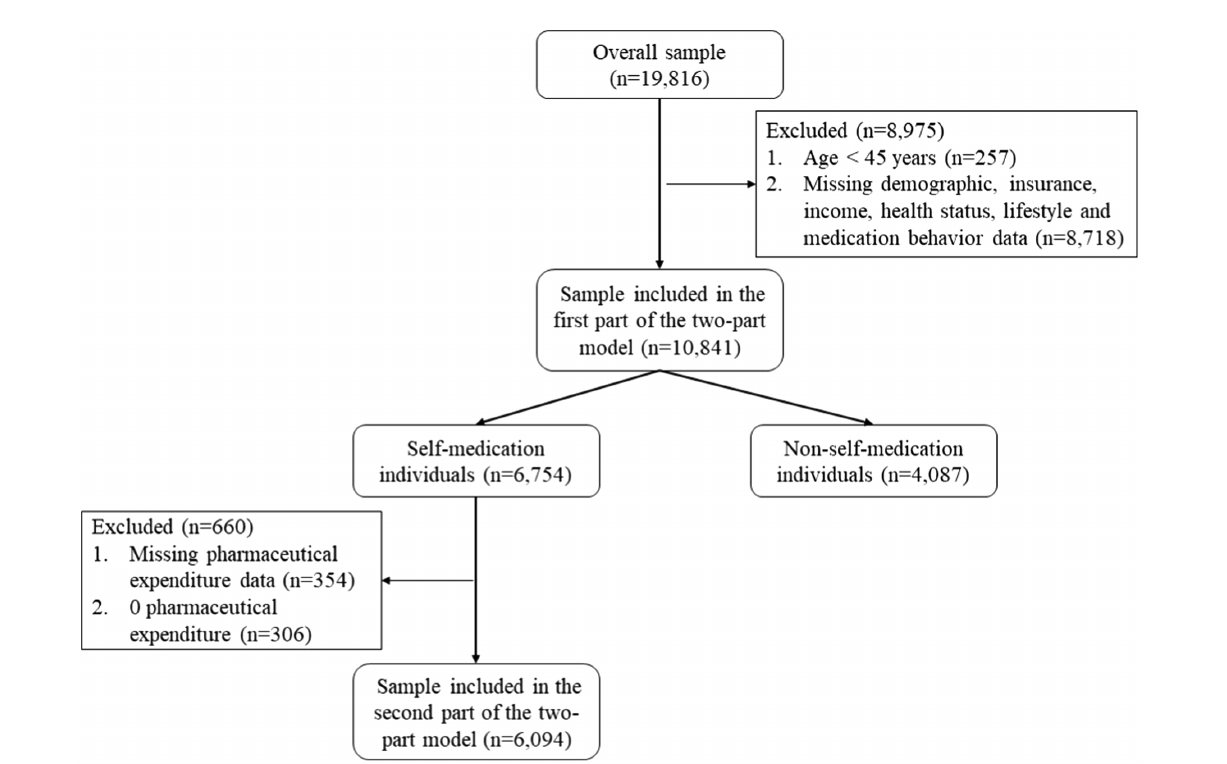
FIGURE 1 Flow chart of the detailed process of enrolling participants in the two-part